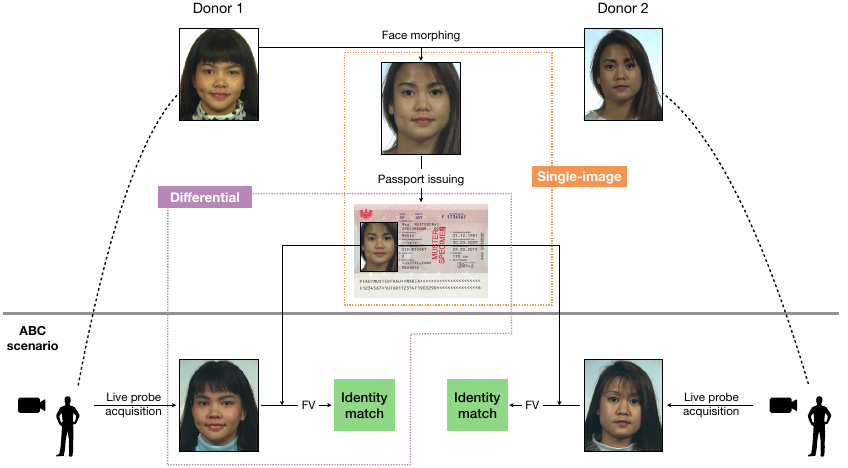
Figure 1. Illustration of a morphing attack against face verification (FV)-based automated border control (ABC) systems (examples are taken from the dataset in [5]): the area of analysis of single-image and differential approaches is